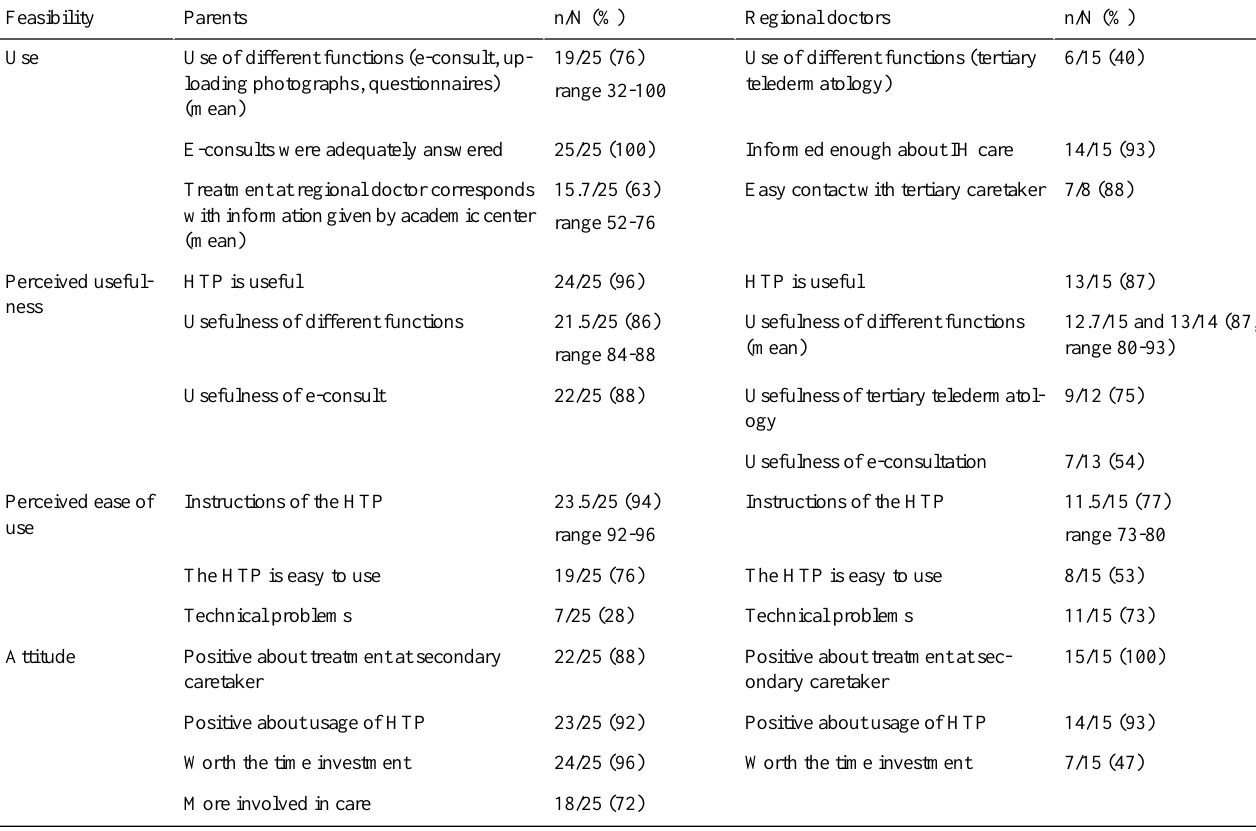
Table 3. Overview of the feasibility of the eHealth intervention sorted by